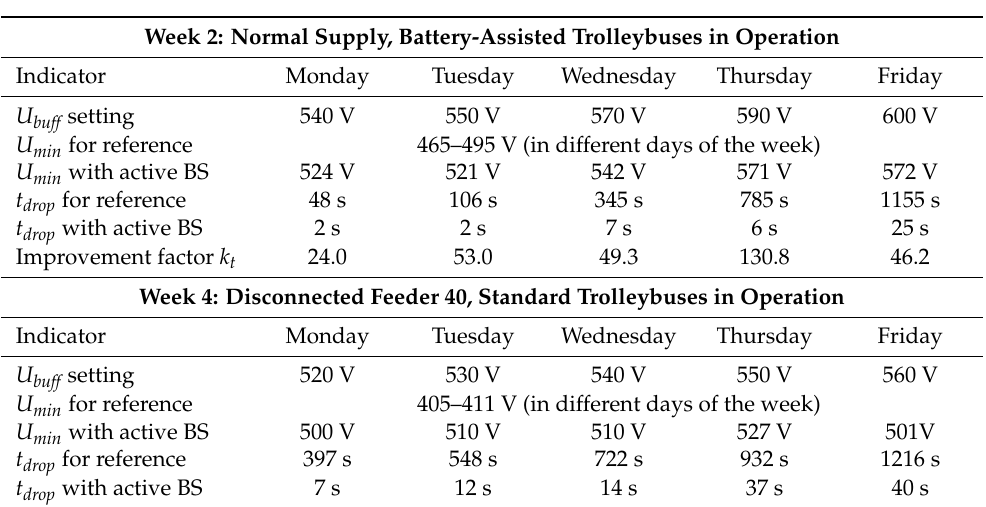
Table 2. Summary of the analysis of effectiveness of voltage drops compensation based on recordings carried out in the buffer station.